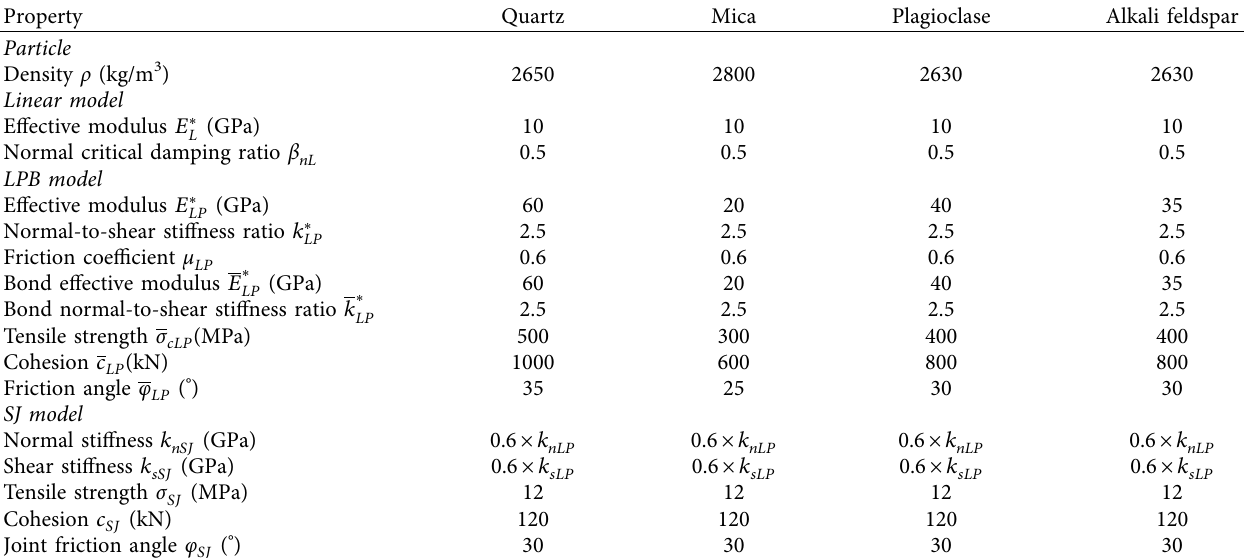
Figure 8: Numerical simulation model of granite: (a) Initial particle set, (b) particle cluster generation, (c) model with particle clusters, (d) models with mineral grouping. Table 1: Micro-parameters of granite